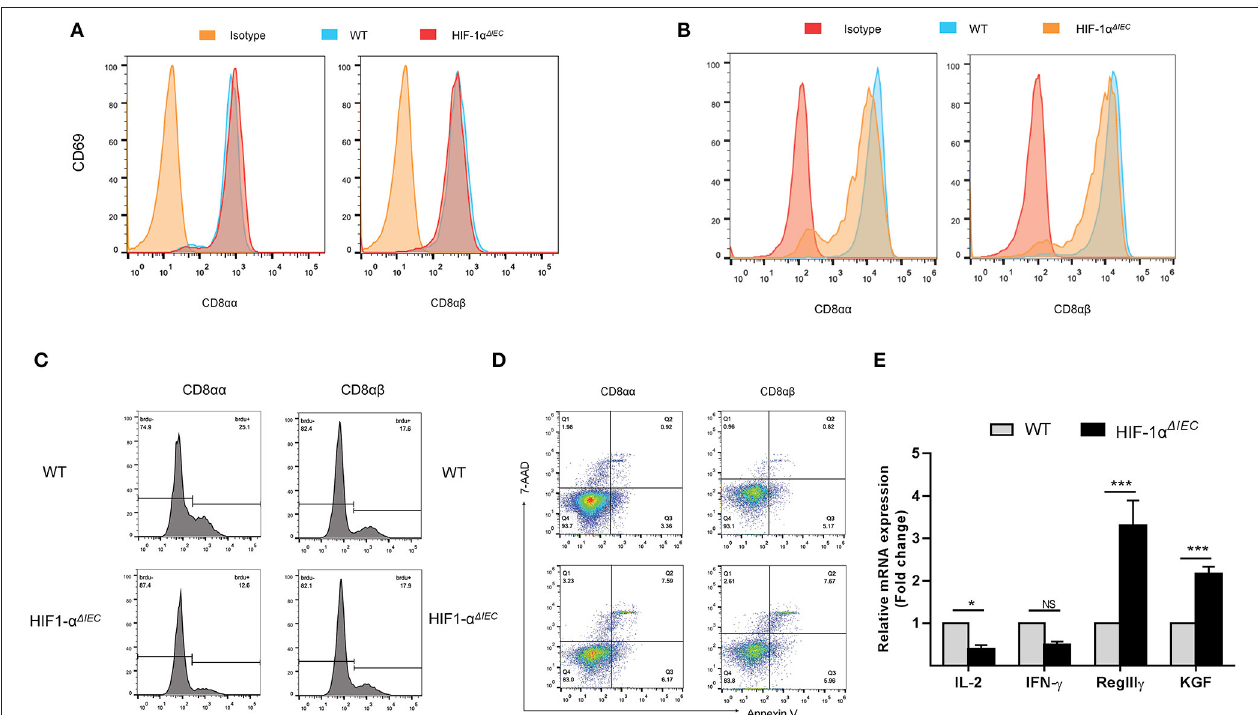
FIGURE 4 | Destruction of IELs homeostasis in Hif1- α ∆ IEC mice is due to the functional changes of CD8 αα + IELs. The surface expression of CD69 (A) and CD103 (B) on CD8 αα + and CD8 αβ + IELs were detected by flow cytometry. (C) WT and Hif1- α ∆ IEC mice were injected with BrdU (2 mg/mouse). After 12h, BrdU incorporation in the CD8 αα + and CD8 αβ + IELs were analyzed, respectively, by flow cytometry. (D) CD8 αα + and CD8 αβ + IELs were examined with apoptosis markers (Annexin V and 7-AAD) by flow cytometry. (E) Changes in the small intestinal IEL-derived cytokine mRNA measured using real-time RT-PCR. Data normalized to β -actin. ( n = 4–7 mice/group). * P < 0.05; *** P < 0.001; NS, not